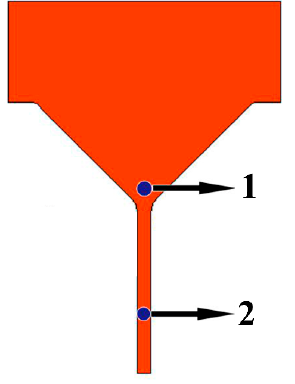
Figure 3. Positions for microstructure observation of the extruded sheet prepared by low-speed Figure extrusion.